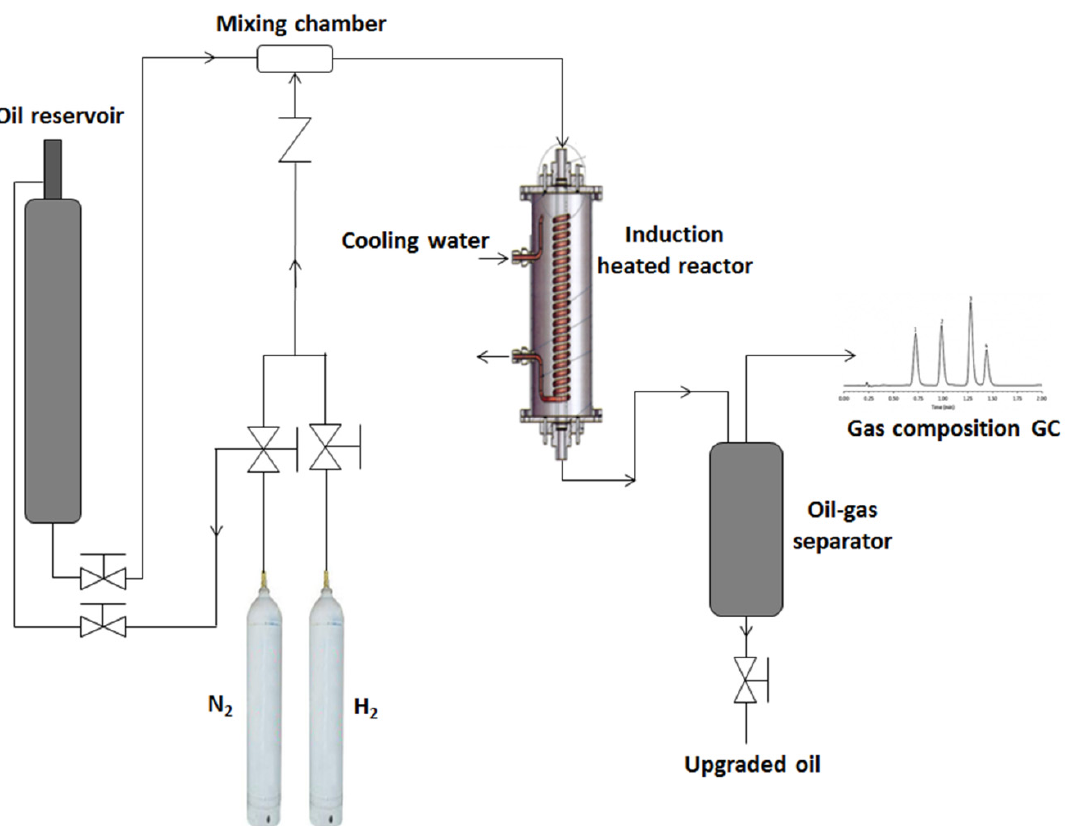
Figure 7. Schematic diagram of the induction heated catalytic reactor setup.